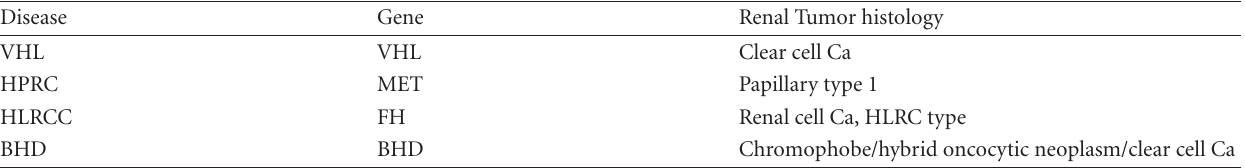
Table 1: Characteristics of autosomal dominant (AD) forms of kidney cancer (adapted from Zbar et al.